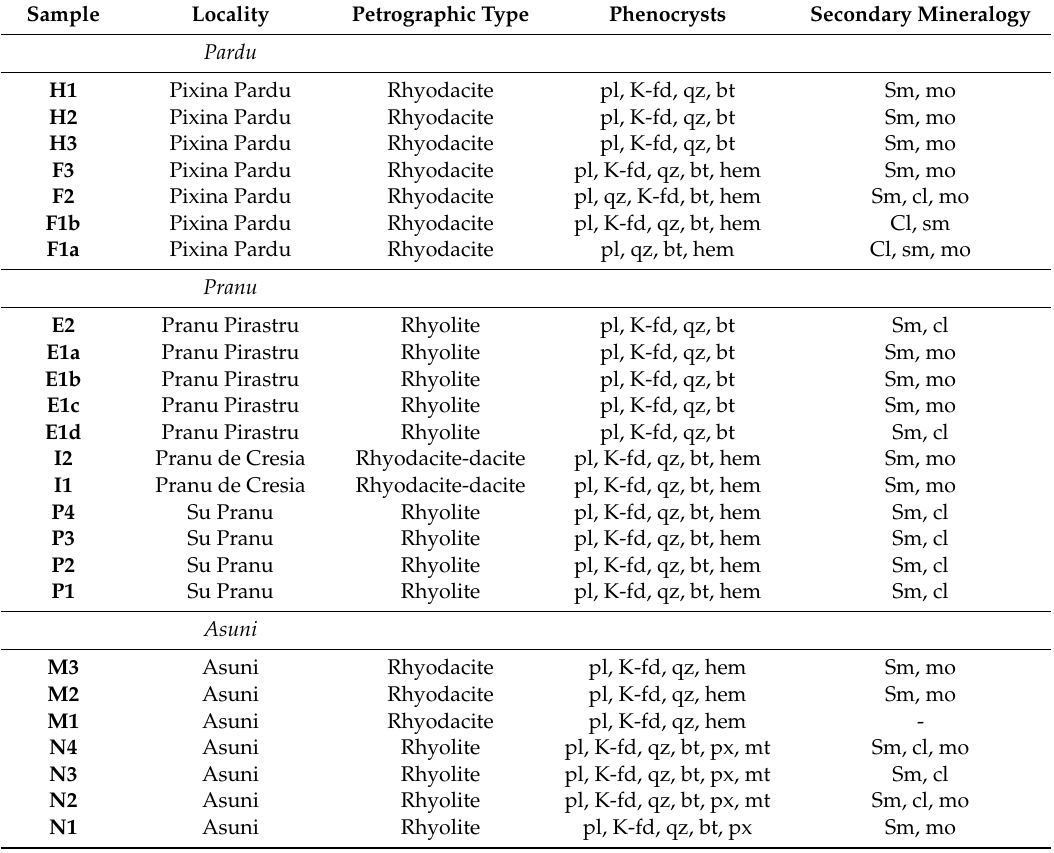
Table 1. Summary of mineralogical and petrographic features of the studied Asuni samples.